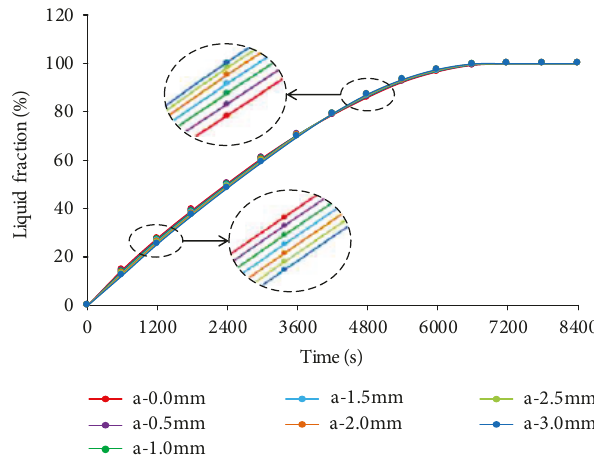
Figure 5: E ff ects of thickness of tube on liquid fraction.